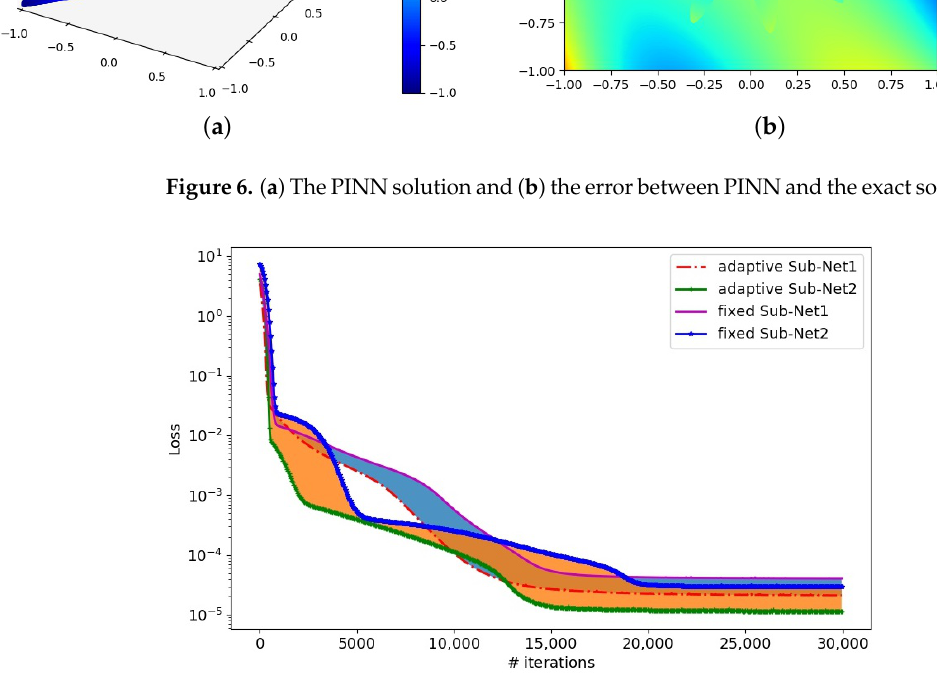
Figure 7. The evolution of average loss error for Example